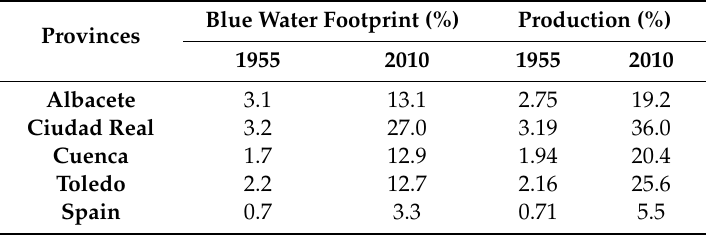
Table 5. Blue water footprint and production: Percentage represented by wine over all crops.